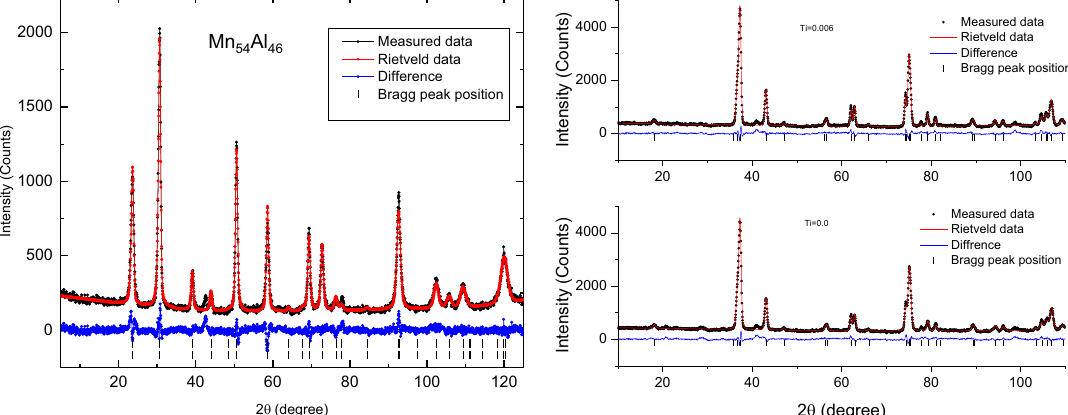
Al (left), and of the Ti doped and undoped Li- 54 46 Mn Ni Ti O (x=0.0, 0.006) cathode material 1.2 0.6-x 0.2 x 2